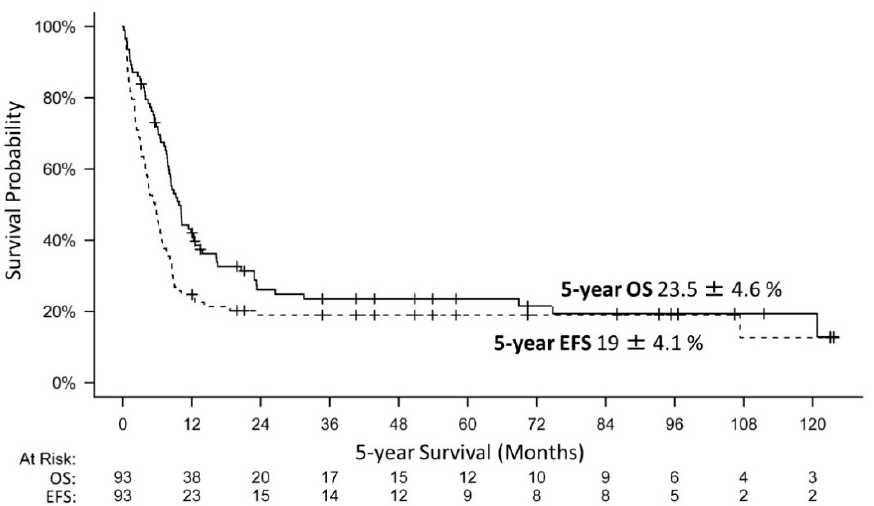
Figure 4. The 5-year overall (OS) and event free survival (EFS) of 93 patients infants with MRT. 7 patients did not receive any chemotherapy, not included in this analysis. The 5-year overall survival (OS) of 93 infants with MRT (ATRT = 41, eMRT = 28, RTK = 9, SYN = 15) was 23.5 ± 4.6%, while the 5-year event free survival (EFS) of the same cohort was 19 ± 4.1%.